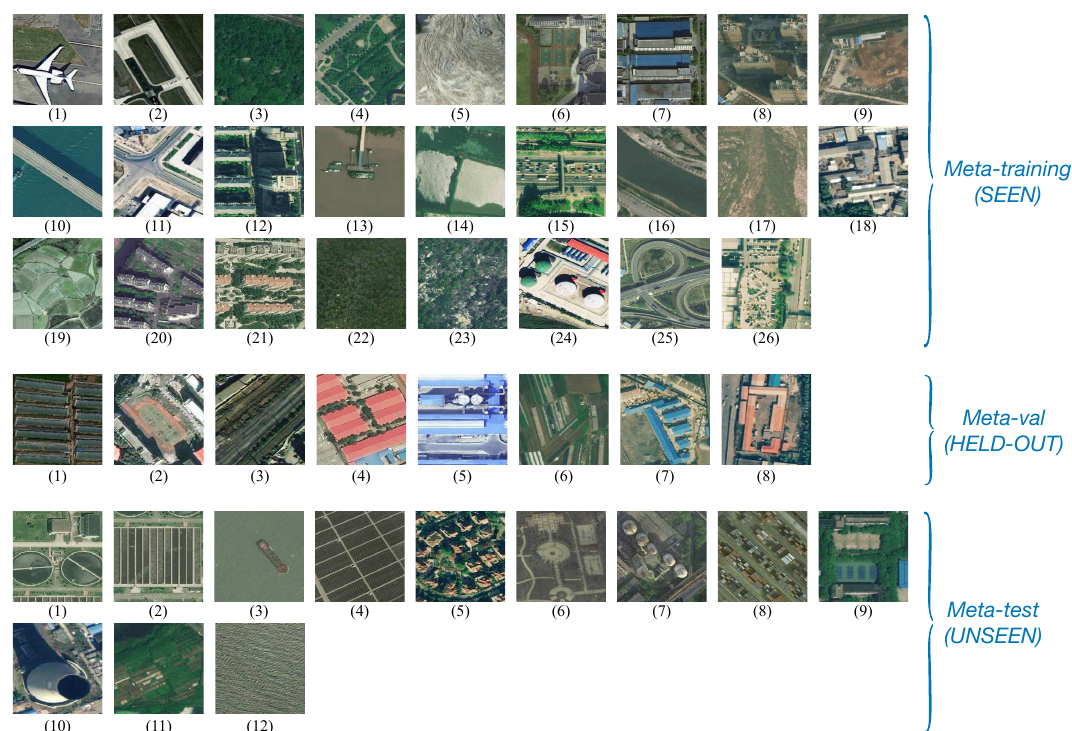
Figure 9. RSD46-WHU Dataset split. Meta-training (SEEN): (1) Airplane, (2) Airport, (3) Artificial dense forest land, (4) Arti- ficial sparse forest land, (5) Bare land, (6) Basketball court, (7) Blue structured factory building, (8) Building, (9) Construction site, (10) Cross river bridge, (11) Crossroads, (12) Dense tall building, (13) Dock, (14) Fish pond, (15) Footbridge, (16) Graff, (17) Grassland, (18) Low scattered building, (19) Lrregular farmland, (20) Medium density scattered building, (21) Medium density structured building, (22) Natural dense forest land, (23) Natural sparse forest land, (24) Oiltank, (25) Overpass, (26) Parking lot; Meta-validation (HELD-OUT): (1) Plasticgreenhouse, (2) Playground, (3) Railway, (4) Red structured factory building, (5) Refinery, (6) Regular farmland, (7) Scattered blue roof factory building, (8) Scattered red roof factory building; Meta-test (UNSEEN): (1) Sewage plant-type-one, (2) Sewage plant-type-two, (3) Ship, (4) Solar power station, (5) Sparse residential area, (6) Square, (7) Steelsmelter, (8) Storage land, (9) Tennis court, (10) Thermal power plant, (11) Vegetable plot, (12)